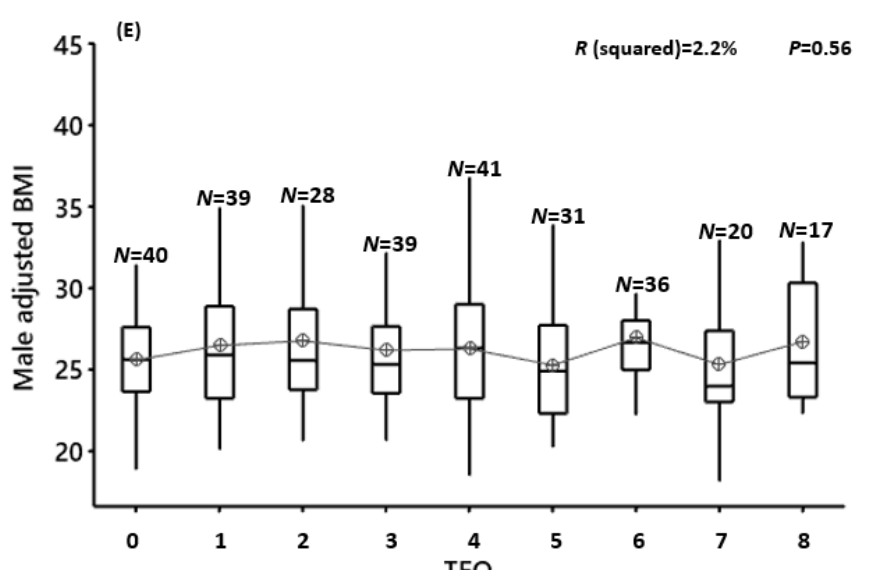
Figure 5. Male adjusted BMI vs. the frequency of food outlet usage for 7-consecutive days. ( A ) FSR = full-service restaurant, ( B ) FFR = fast-food restaurant, ( C ) delivery, ( D ) take-away and ( E ) TFOs = total food outlets, N = number of participants in each group. Results of the ANOVA are shown. Significance is where p < 0.01 (after Bonferroni correction).